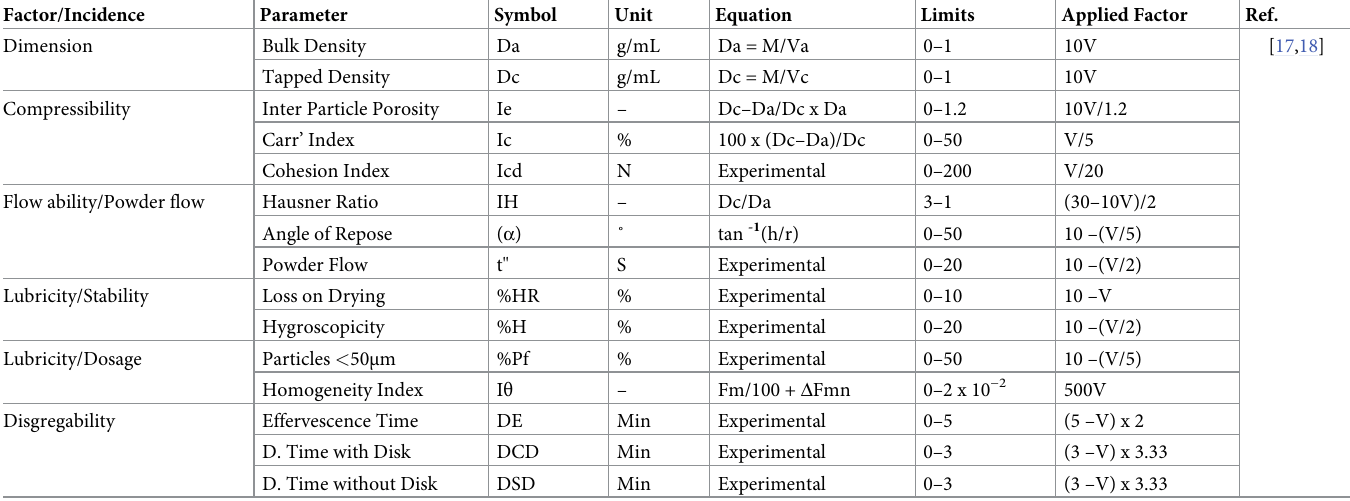
Table 3. Basic parameters, range of acceptable limits and applied factors of SeDeM-ODT experts system.